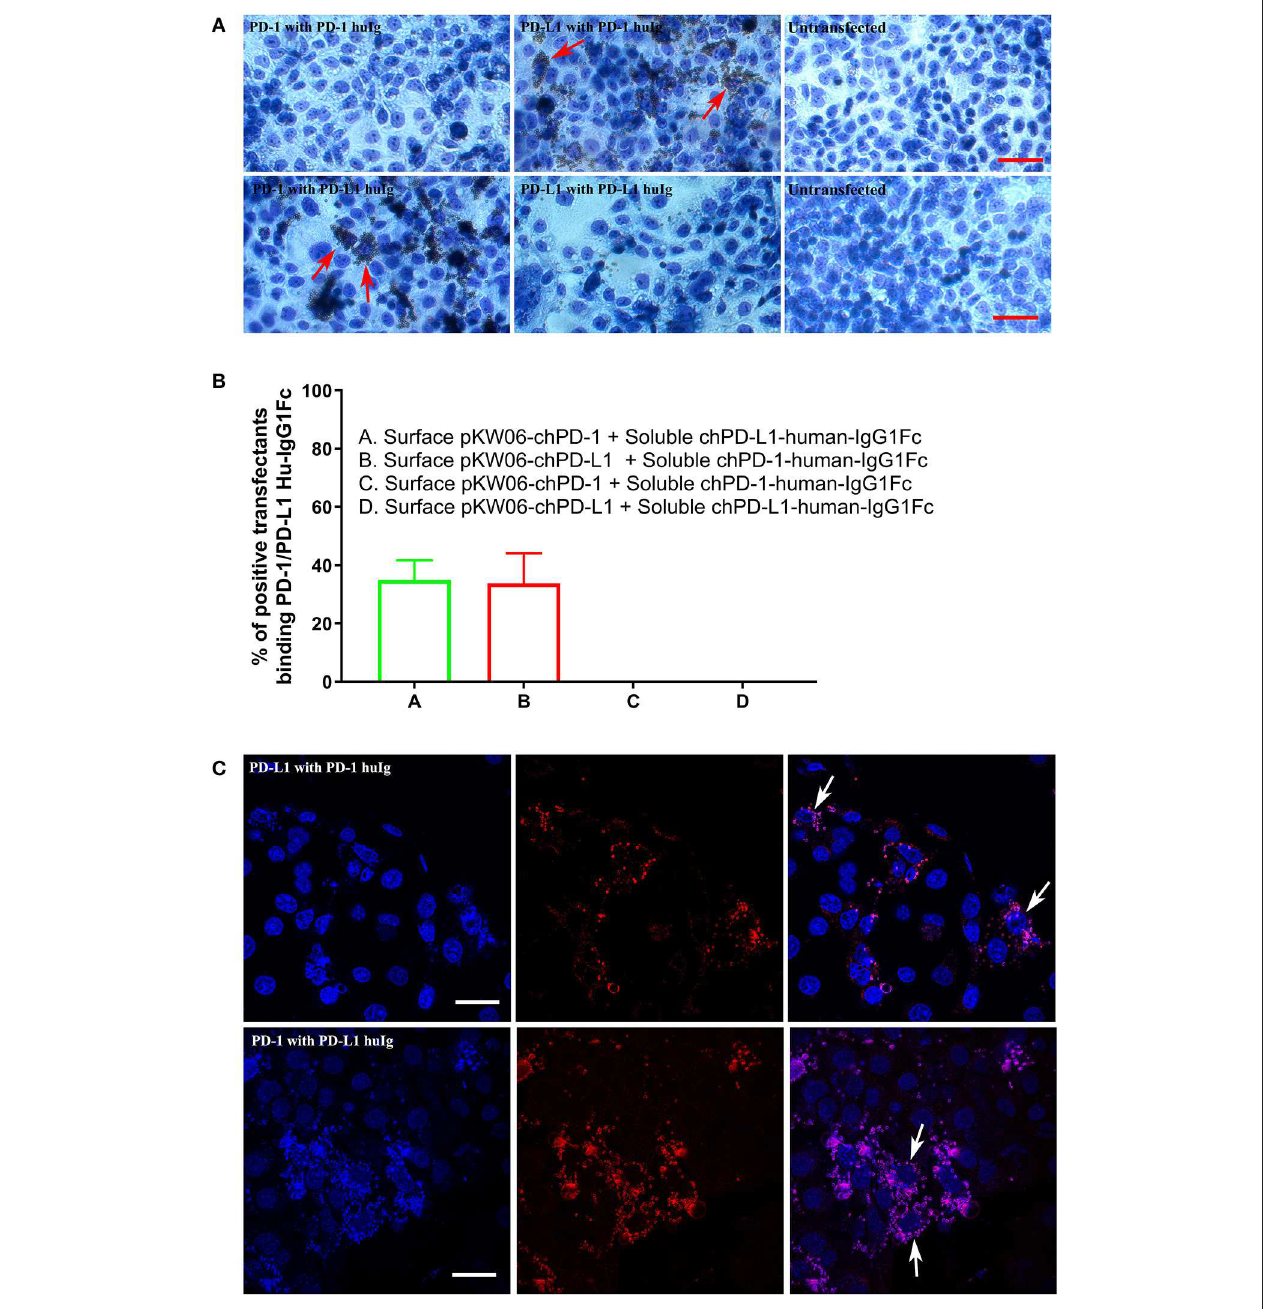
FIGURE 4 | Binding interactions of recombinant soluble chPD-1/PD-L1 with surface chPD-1/PD-L1 on COS cells. (A) Representative EVOS images illustrating chPD-1 and chPD-L1 interactions. Images were taken using an EVOS digital microscope. Giemsa staining was carried out on COS cells transfected with surface expression constructs pKW06-chPD-1and pKW06-chPD-L1. Rosette formation was observed when surface pKW06-chPD-L1 interacts with soluble chPD-1-human-IgG1Fc fusion protein (red arrows) and surface pKW06-chPD-1 with soluble chPD-L1-human-IgG1Fc fusion protein (red arrows). No rosettes was observed in surface pKW06-chPD-1 with soluble chPD-1-human-IgG1Fc fusion protein interaction, surface pKW06-chPD-L1 with soluble chPD-L1-human-IgG1Fc fusion protein interaction, and untransfected cells. Scale bar represents 50 µ m. (B) Percentage of soluble chPD-1/PD-L1-human-IgG1Fc fusion proteins interactions with surface pKW06-chPD-1/PD-L1 were calculated by counting 10 randomly selected fields by scoring COS cells with 5 or more beads as positive. On surface pKW06-chPD-1 and pKW06-chPD-L1 transfected COS cells, 34.89 ± 6.8% of chPD-L1-human-IgG1Fc and 33.79 ± 10.3% of chPD-1-human-IgG1Fc showed clear rosette structures, respectively. Data are represented as means of three independent biological experiments ± standard deviation (error bars). (C) Representative confocal photo micrographs illustrating clear rosette (white arrows) formation during chPD-1 and chPD-L1 interactions. Red fluorescence visualizes Dynabeads ® . Scale bar represents 40 µ